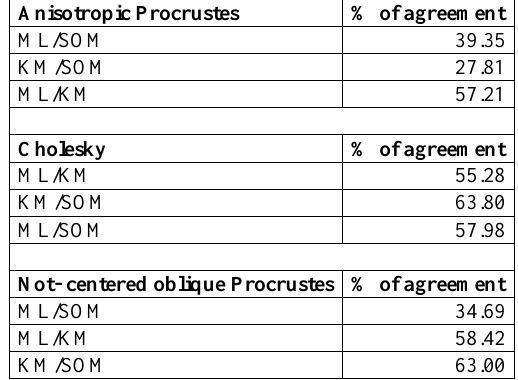
Table 2: Agreement between classifier results relative to different deshadowing methods